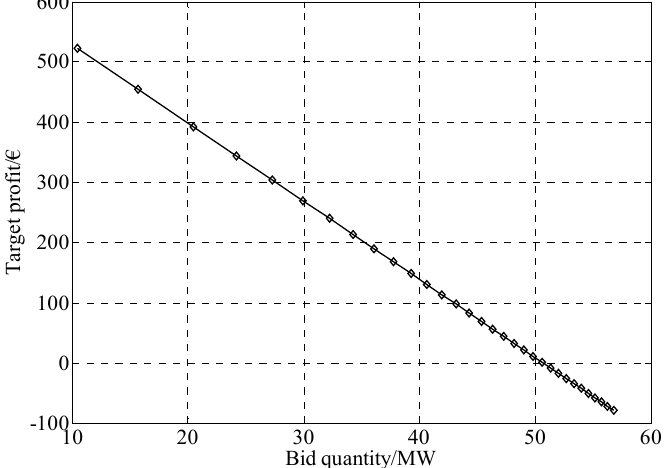
Figure 7. Target profit versus bid quantity under EPCS with 1 − β =